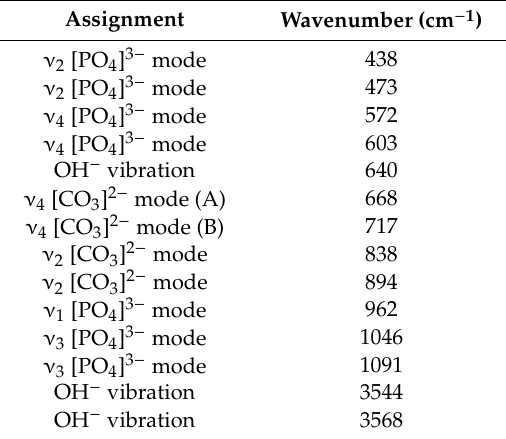
Table 4. The FTIR spectrum band assignment of hydroxylapatite from Muránska Dlhá Lúka according to [38,39].